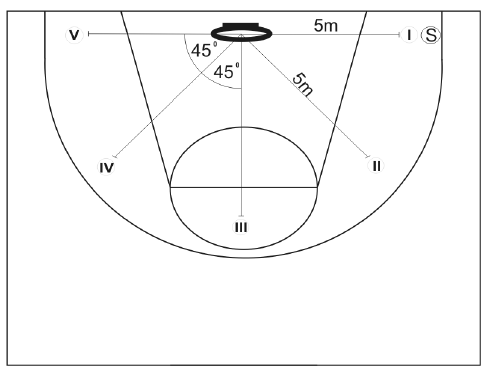
Figure 2. The stationary two-point shooting test (S2P) Legend. S =